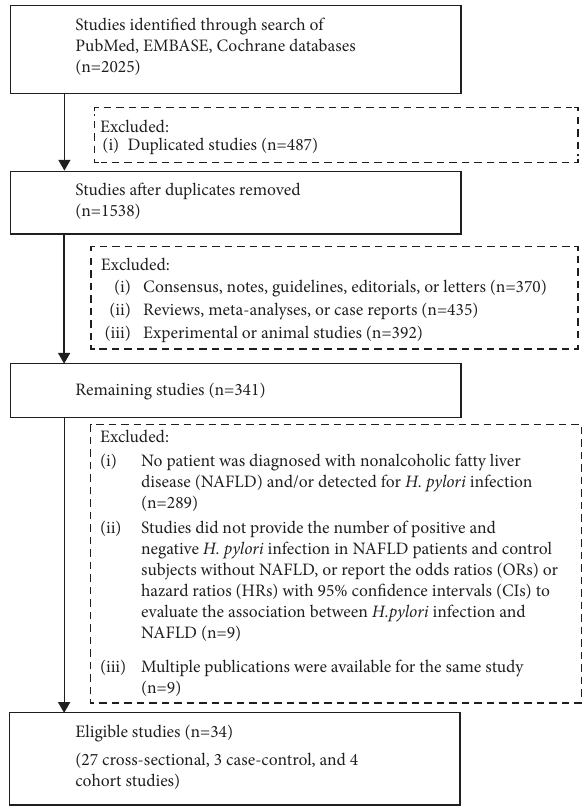
Figure 1: Flowchart of the study selection